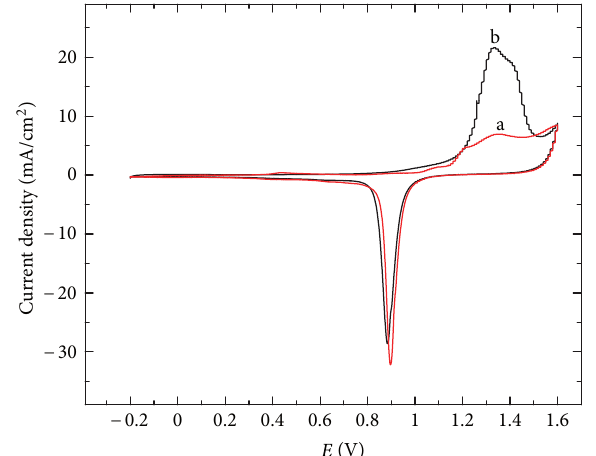
F 4: CV of (a) AuNPs electrode and (b) C SO solution. Scan rate = 50 mV/s. aqueous 0.5 M H 2 4